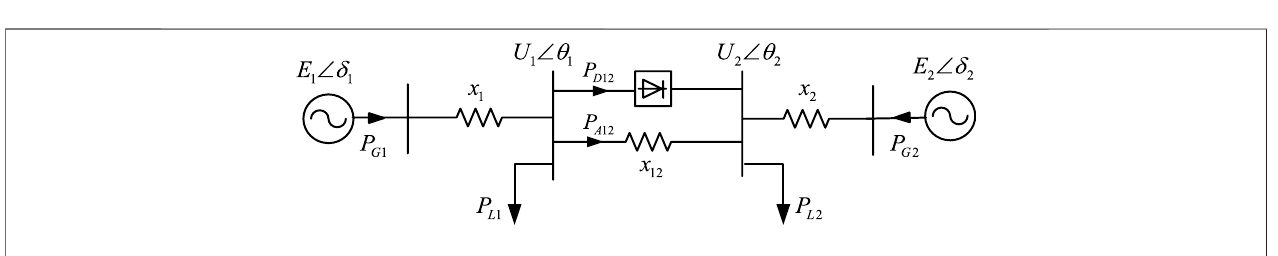
FIGURE 3 | The equivalent model of system in Figure